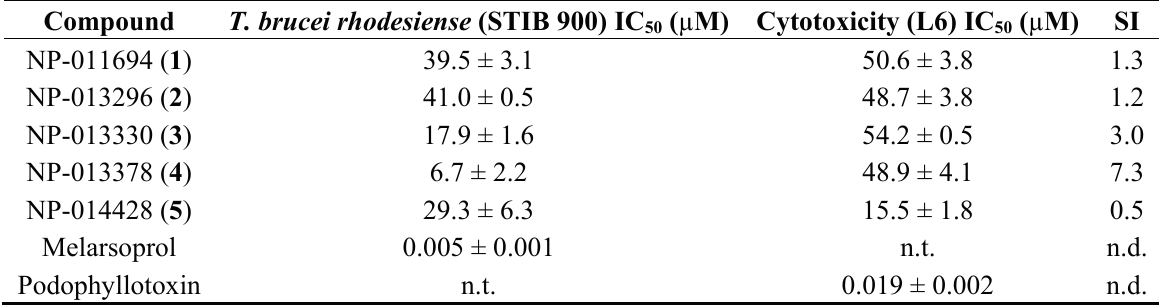
Table 2. In vitro antitrypanosomal and cytotoxic activity of Compounds 1 – 5 . Each value represents the mean ± margin of deviation of two independent